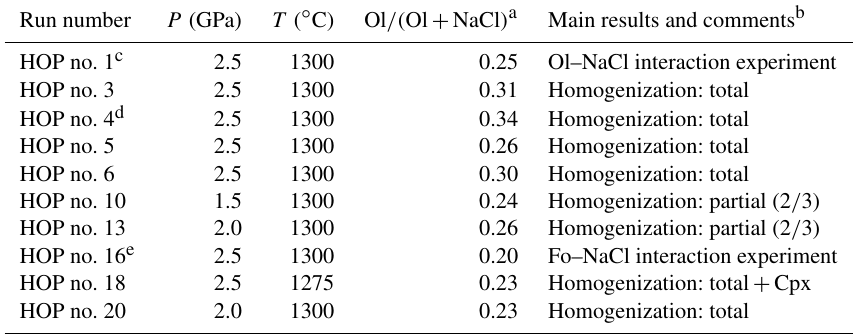
Table 1. Summary of experimental parameters (run duration was 30min in all experiments). Cpx: clinopyroxene; Fo: forsterite; Ol: olivine.